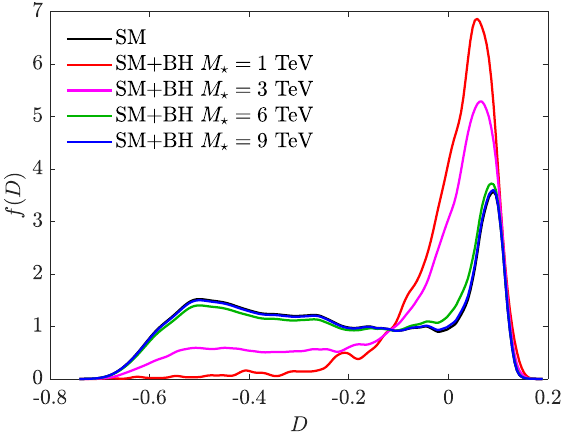
Figure 12 . Probability distribution of the distance from the hadron line D assuming SM only processes (black) and SM with BH production in the cases where M ? = 1 TeV (red), 3 TeV (pink), 6 TeV (green) and 9 TeV (blue). E (cid:0) 2 neutrino spectrum is applied with (1:1:1) (cid:13)avor ratio and a minimum energy deposition of 20 PeV.